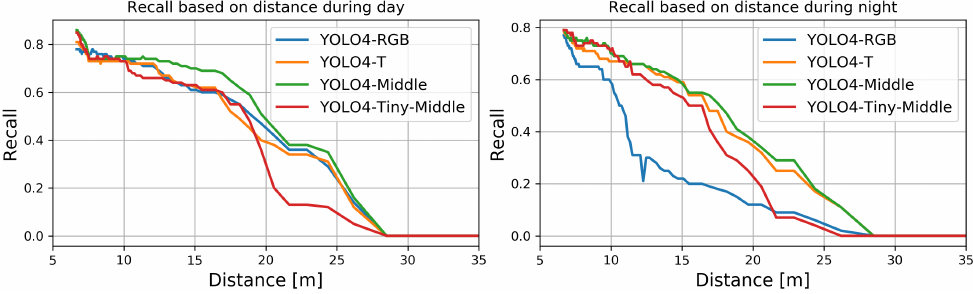
Figure 11. The recall for YOLO4-RGB, YOLO4-T, YOLO4-Middle, and YOLO4-Tiny-Middle as a function of distance (sizes of bounding